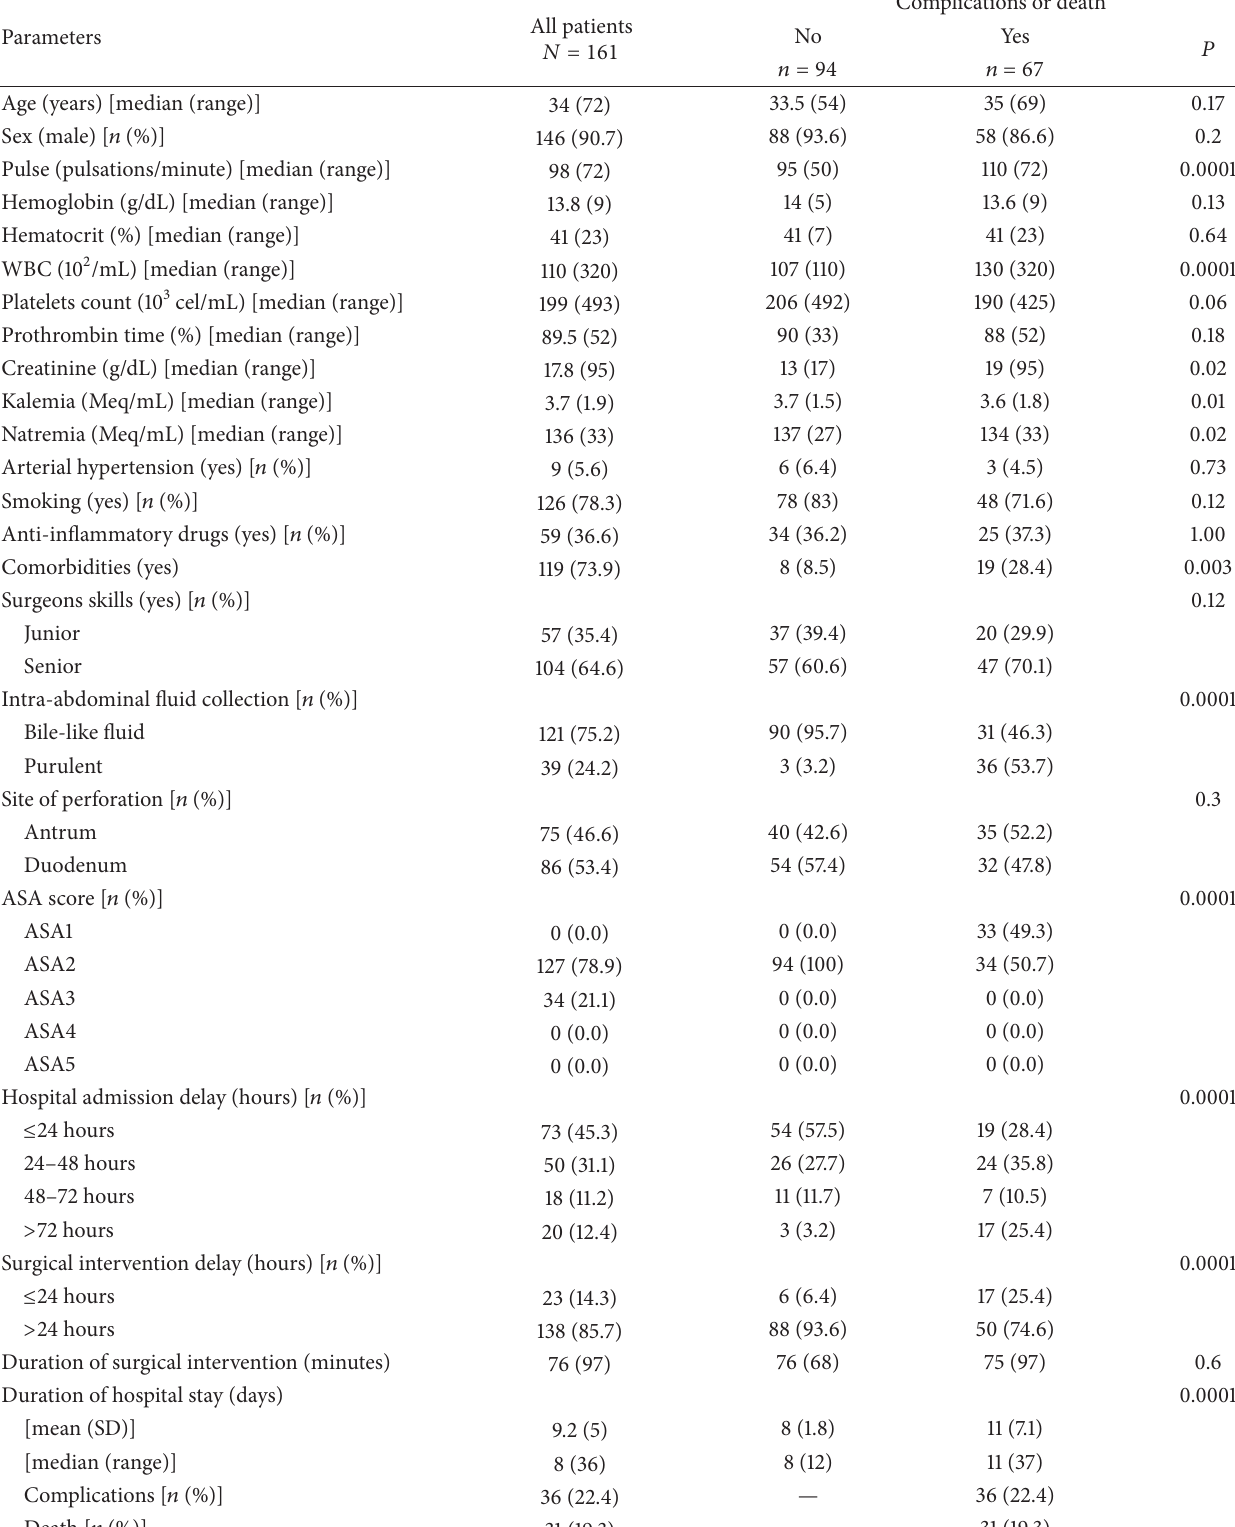
Table 1: Demographic, clinic, and biologic